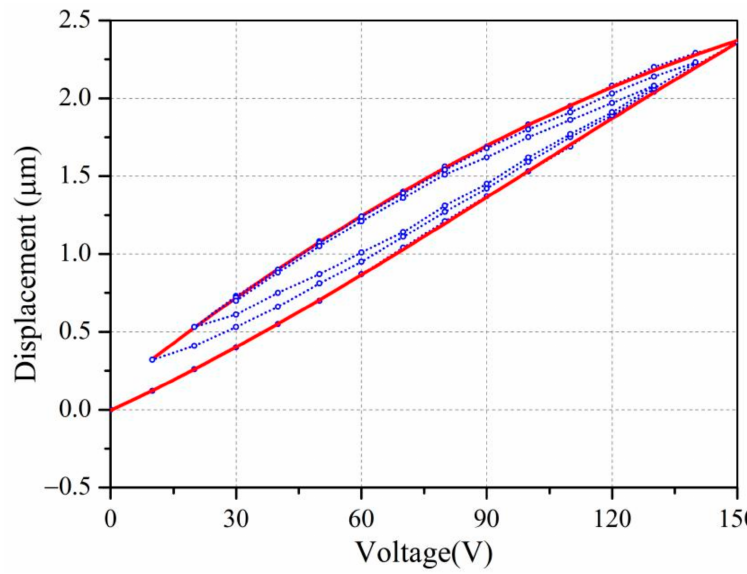
Figure 3. Hysteresis curves of the